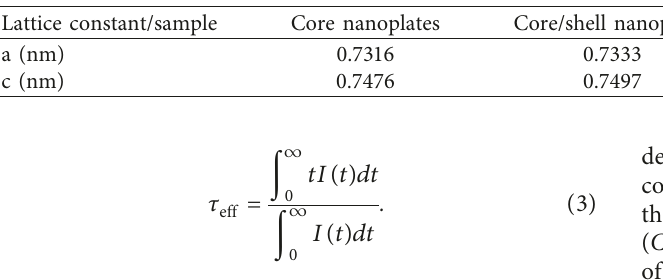
Figure 3: XRD patterns of the (a) core nanoplates and core/shell nanoplates and (b) core nanospheres and core/shell nanospheres. Normalized XRD patterns of the (c) core nanoplates and core/shell nanoplates and (d) core nanospheres and core/shell nanospheres. Table 1: Lattice constants of the